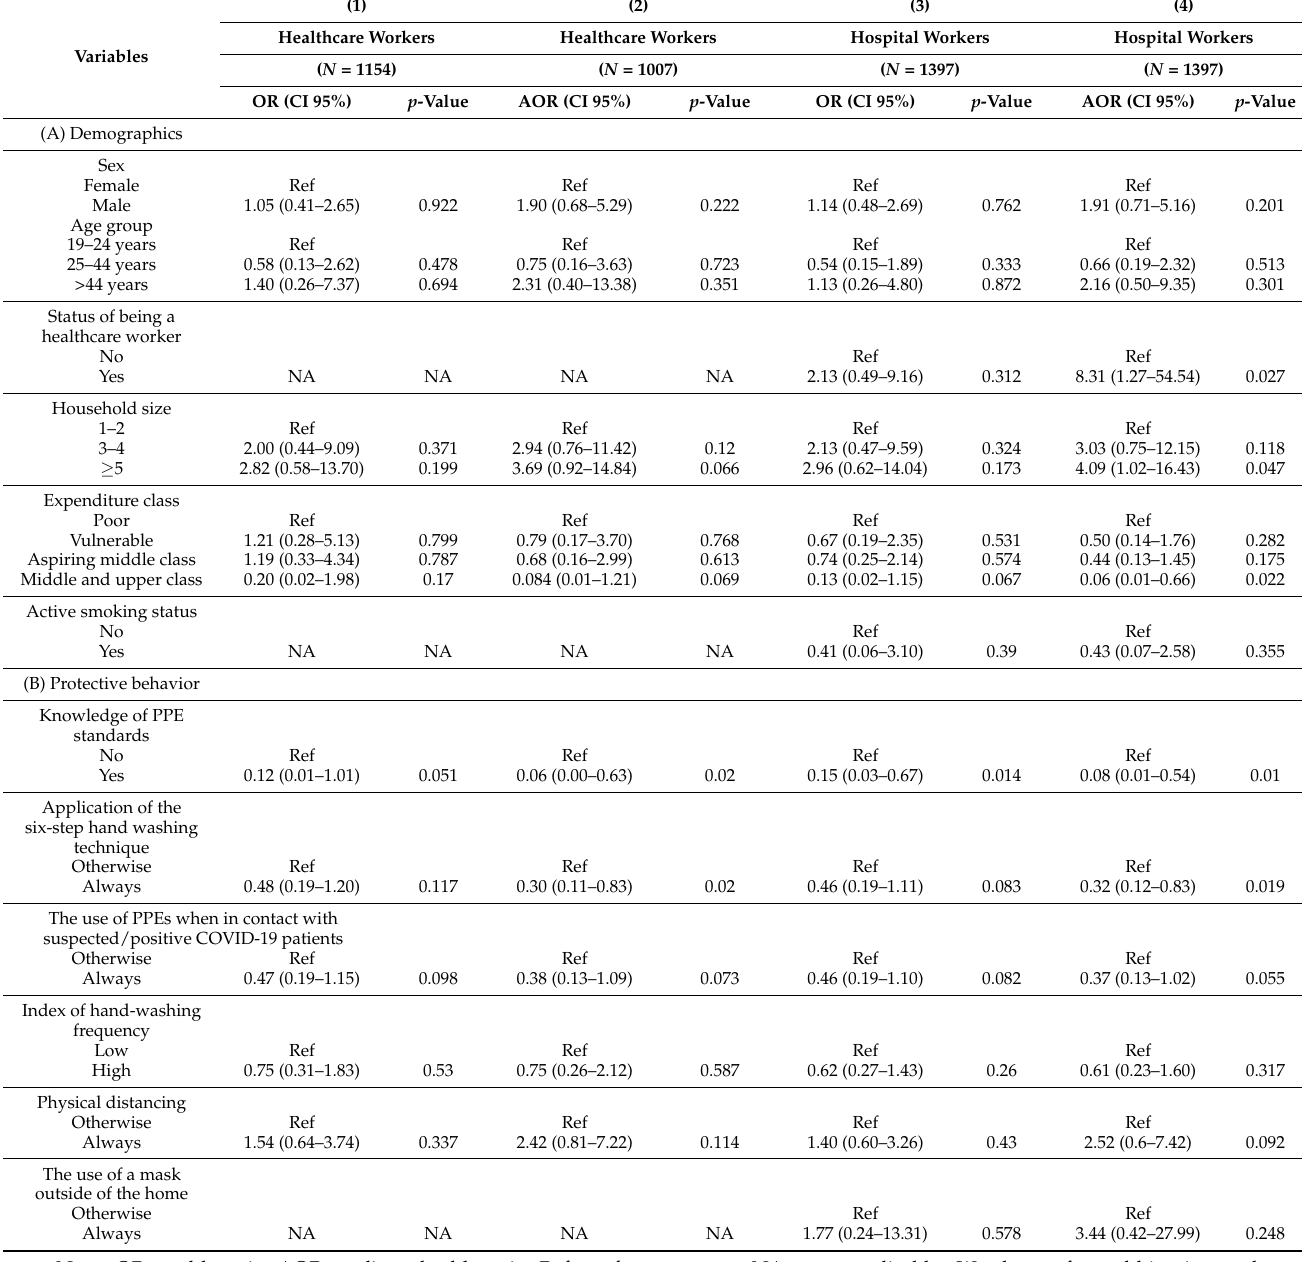
Table 2. Unadjusted and adjusted odds ratios of factors associated with COVID-19